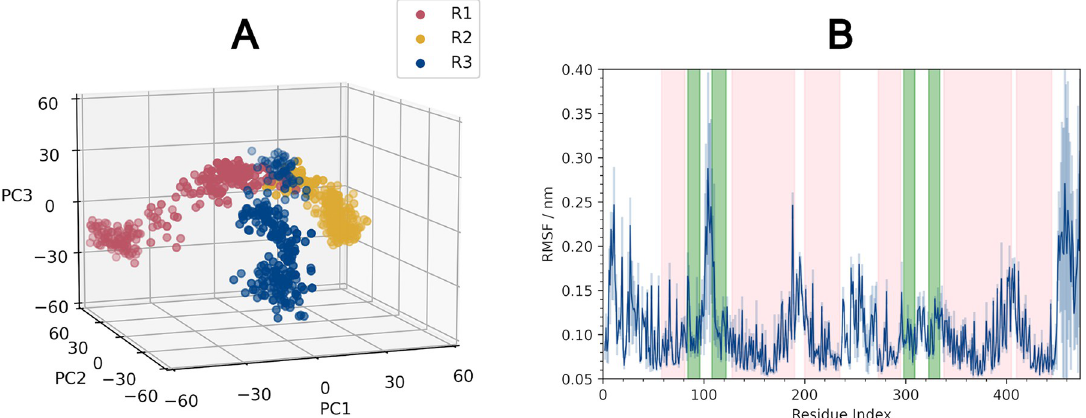
Fig 2. Analysis of the protein dynamics. (A) Projections of the backbone trajectories of each replicate along the first three eigenvectors. Each replicate samples a different conformational space, each unique from the crystal structure. (B) Root-mean-square fluctuation (RMSF) by residue (calculated from the protein backbone, averaged across the three protomers in each of the three replicates). Average trace shown as a solid blue line, associated standard deviation shown in pale blue. Background coloured by secondary structure: pink = α -helices, green = β -sheets, white = no formally defined secondary